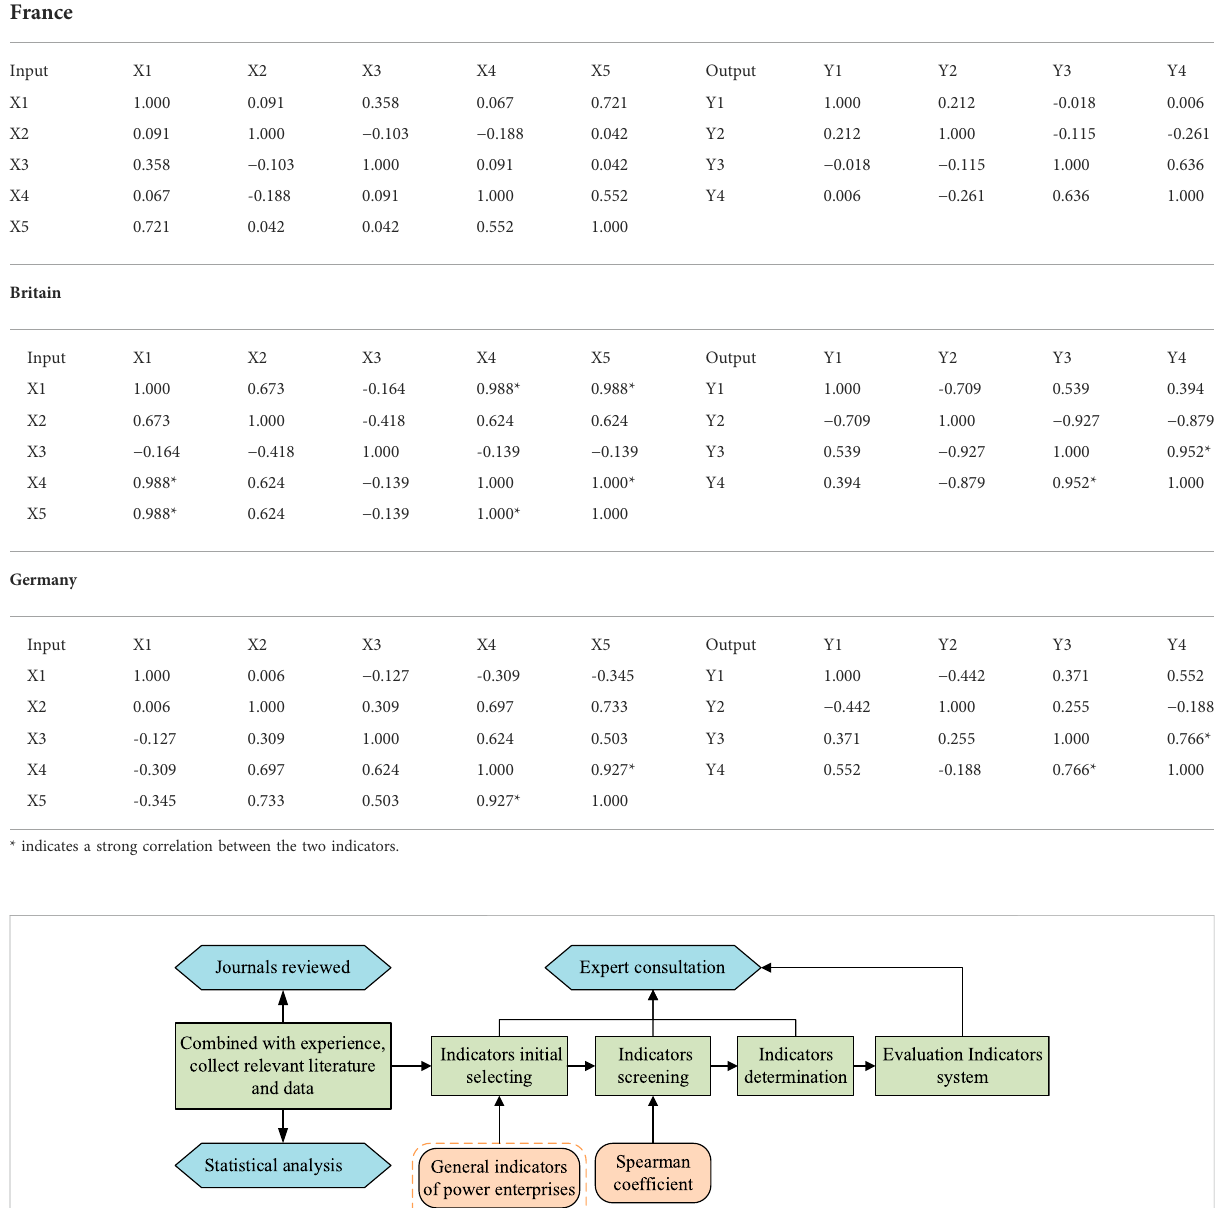
TABLE 4 Spearman correlation of macro index data.